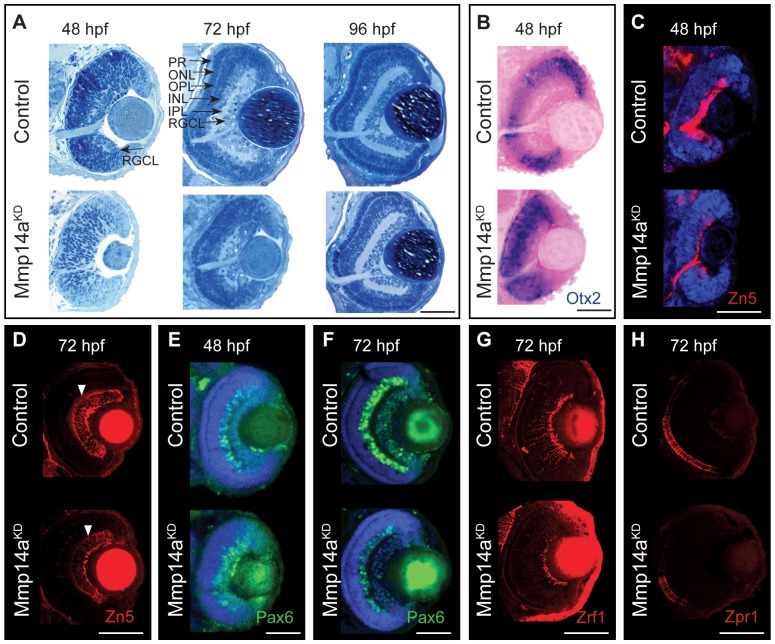
Mmp14a is required for timely differentiation of retinal neurons.
A Toluidine blue stained transverse semi-thin sections show a delay in retinal differentiation and lamination in Mmp14a morphant eyes (Mmp14aKD). At 48 hpf, control embryos show an initial laminated retina, which develops into a fully laminated and differentiated retina at 72 hpf, with a clearly distinguishable RGCL, IPL, INL, OPL, ONL, and PR. Mmp14a morphant retinas, however, completely lack lamination at 48 hpf, while at 72 hpf the degree of lamination is still severely reduced, as compared to control embryos. At 96 hpf, however, morphant retinas appear fully laminated and differentiated and are indistinguishable from control retinas. B
In situ hybridization for otx2 shows increased expression in the central retina of transverse eye sections of morphant embryos as compared to controls. Nuclear Fast Red was used as counterstain. C–H Immunohistochemical stainings for markers of neuronal differentiation on transverse sections of Mmp14a morphant and control embryos reveal a reduced expression of Zn5 (red), which stains RGCs and their axons, in Mmp14a morphants at 48 hpf (C) and 72 hpf (D, white arrowhead shows RGC dendrites), of Pax6 (green), which labels RGCs and amacrine cells, at 48 hpf (E) and 72 hpf (F), of the Müller glia marker Zrf1 (red) (G), and of the photoreceptor marker Zpr1 (red) (H), both at 72 hpf, all indicative for a disrupted retinal differentiation. DAPI (blue) was used as counterstain in C, E, F. The images in panel D, G and H were taken using confocal microscopy. hpf, hours post fertilization; INL, inner nuclear layer; IPL, inner plexiform layer; ONL, outer nuclear layer; OPL, outer plexiform layer; PR: photoreceptor layer; RGCL, retinal ganglion cell layer. Scale bars: 50 µm.